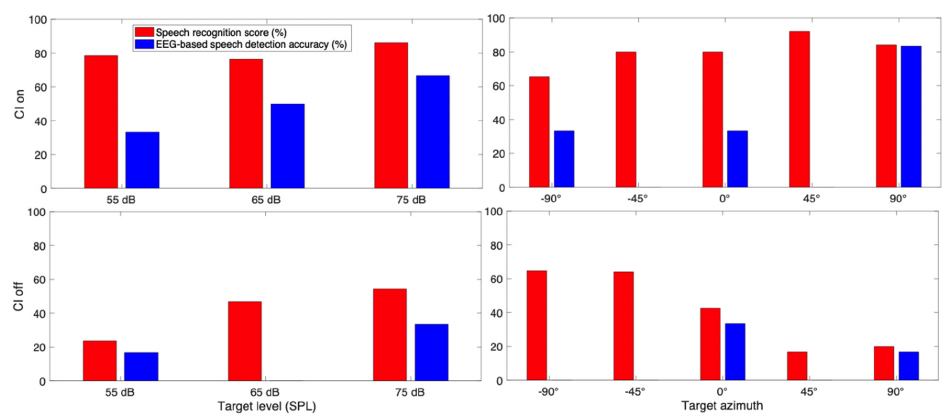
Figure 10. Speech recognition score and speech detection accuracy from EEG for CI 7.